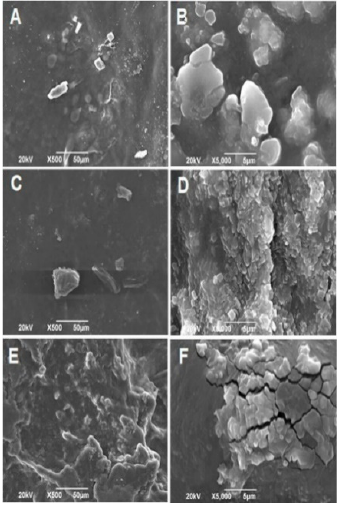
Figure 5. SEM images of the electrospun CS / PVA / GO composite nanofibrous membranes after fourteen days in the degradation process in SBF. ( A , B ) 0% GO, ( C , D ) 0.5% GO, and ( E , F ) 1.0 % GO. Images ( A , C , E ) at 500 × , and images ( B , D , F ) at 10,000 × . For all the experiments, the voltage used was 20